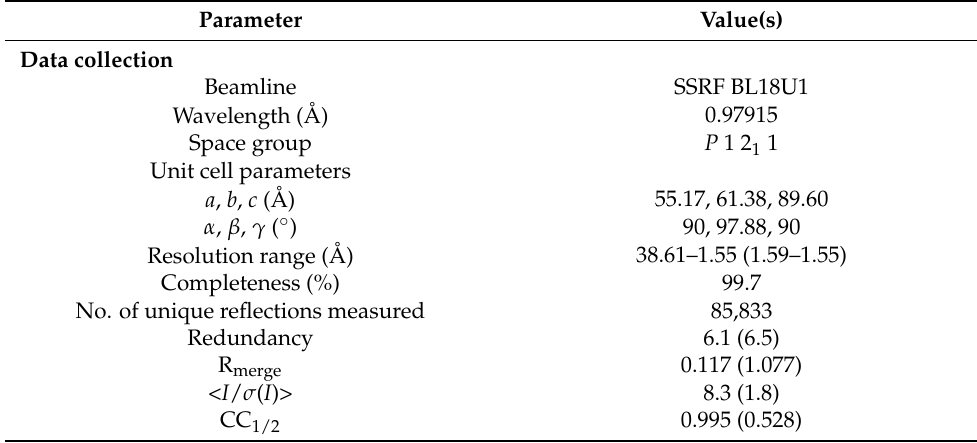
Table A1. Diffraction data collection and refinement statistics of PaAst